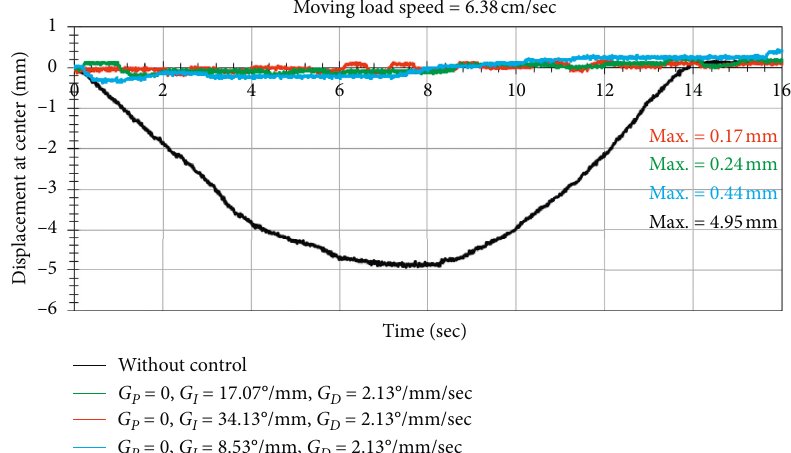
Figure 12: Comparison of the time histories of displacement responses for the bridge under a load of a low-speed vehicle without and with NEM control and various gain coefficients.